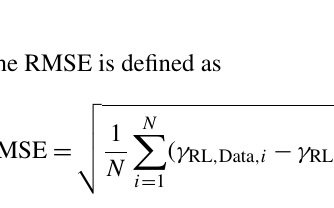
Figure 9. Squared coherence between the REWS estimation of the lidar and the turbine for region 1. The two models are also included in the